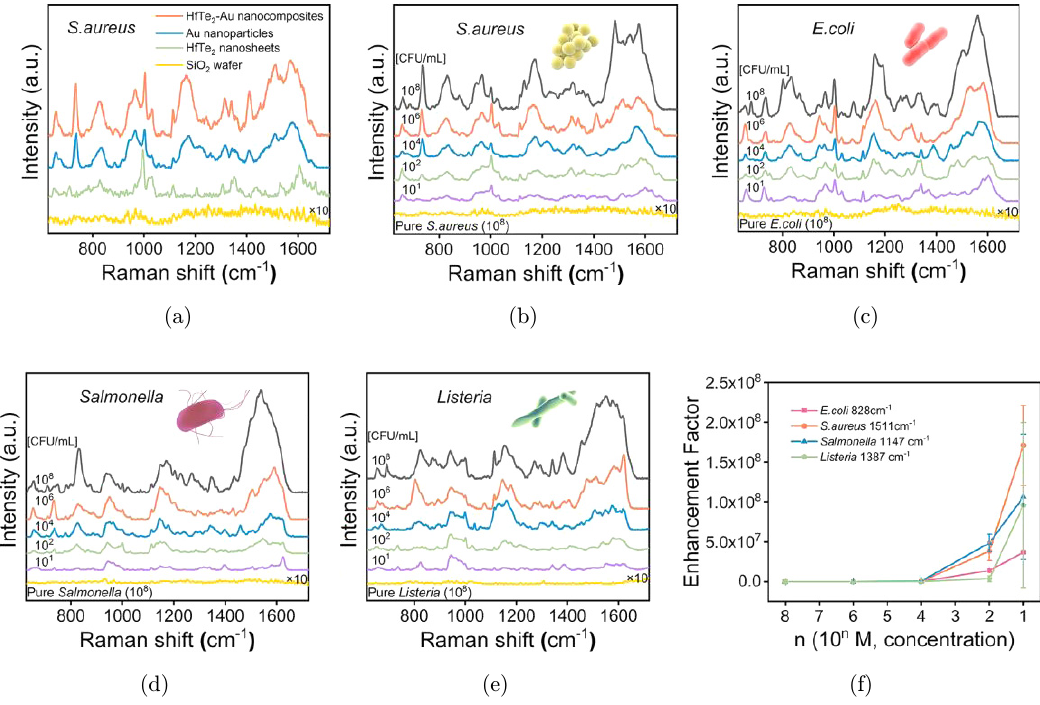
Fig. 6. (a) Raman spectra of S. aureus deposited on HfTe 2 -Au nanocomposites, Au nanoparticles, HfTe 2 nanosheets and SiO 2 wafer, respectively. SERS spectra of (b) S. aureus , (c) E. coli , (d) Salmonella and (e) Listeria on HfTe 2 -Au substrate at the concentrations of 10 8 , 10 6 , 10 4 , 10 2 and 10 1 CFU/mL. (f) The EF values of typical Raman peaks of four bacteria on HfTe 2 -Au